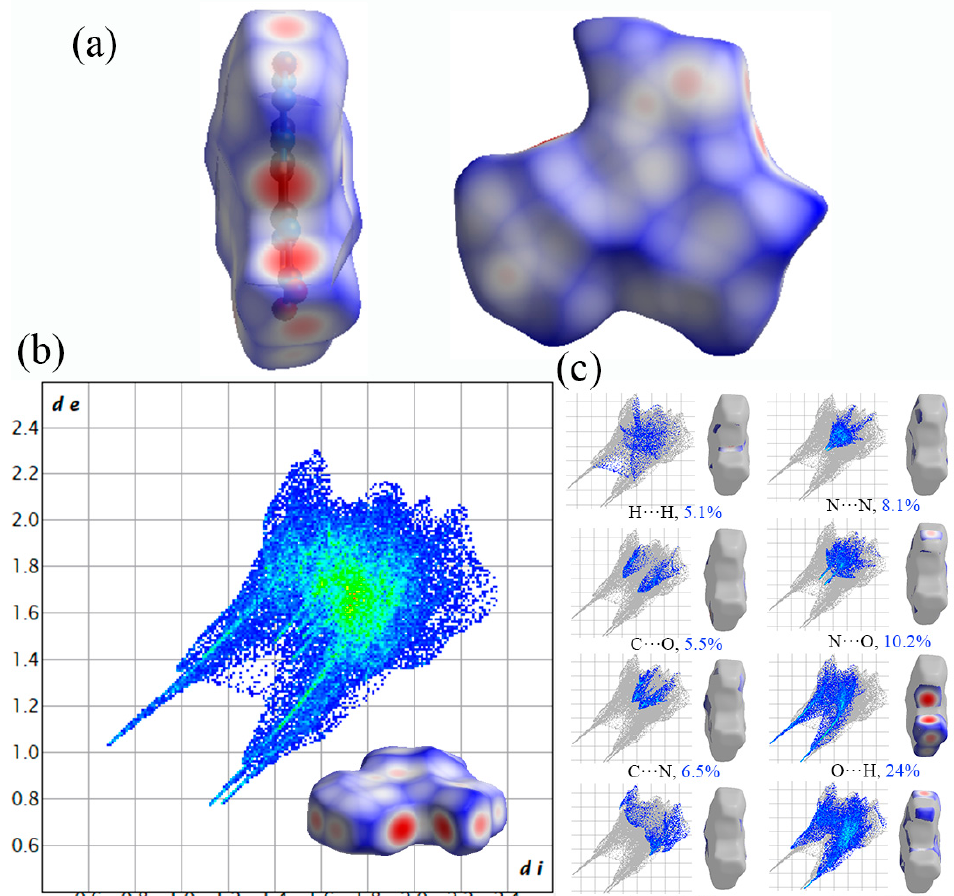
Figure 7. Hirshfeld surfaces and the corresponding 2D fingerprint plot of Crystal c : ( a ) Hirshfeld surfaces; ( b ) 2D fingerprint plots; ( c ) populations of close interatomic contacts.